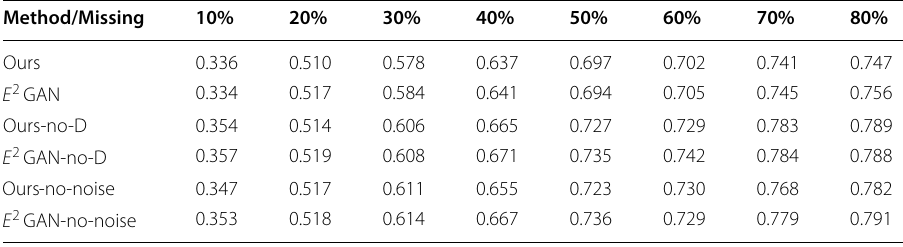
Table 2 The effects of the discriminator and random noise η on the proposed method and E 2 GAN